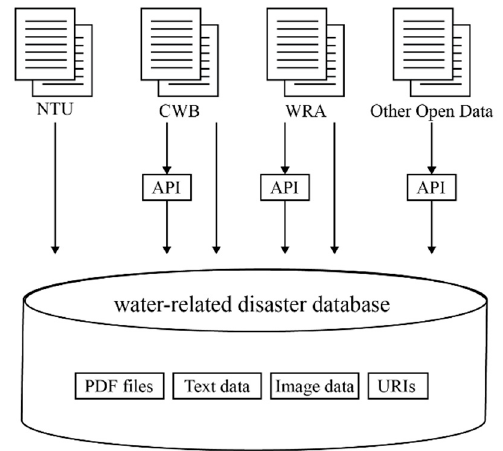
Figure 4. The data sources of Ask Diana.